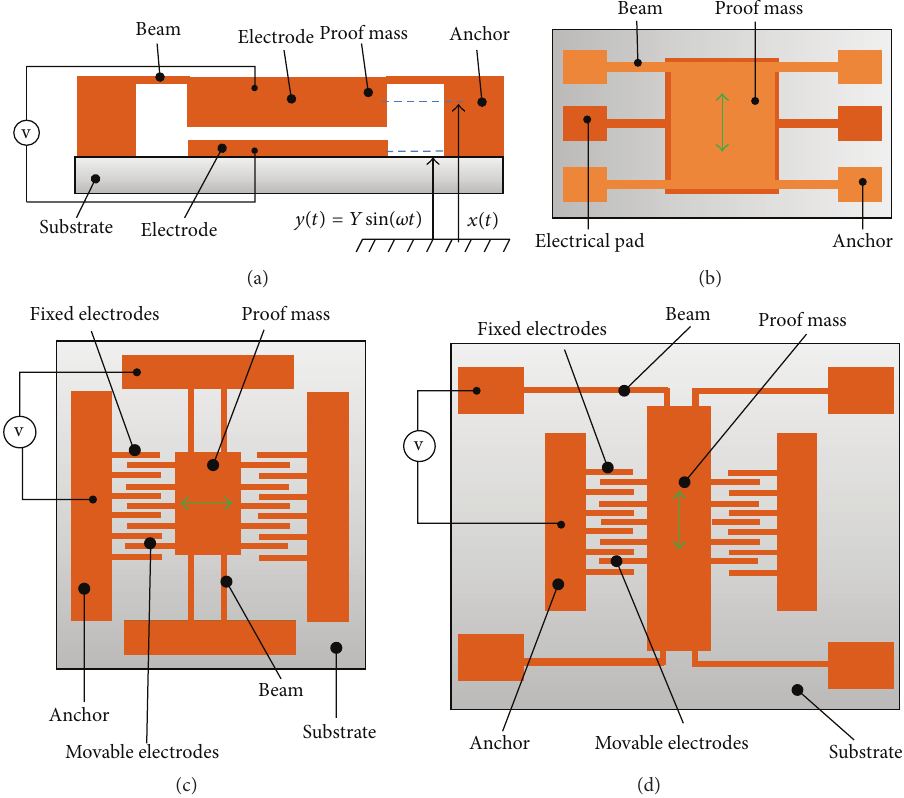
Figure 3: Schematic diagram of ES-VEHs: (a) out-of-plane gap varying type ES-VEH, (b) in-plane, overlap area varying ES-VEH, (c) comb type overlap area varying ES-VEH, and (d) comb type gap varying ES-VEH.